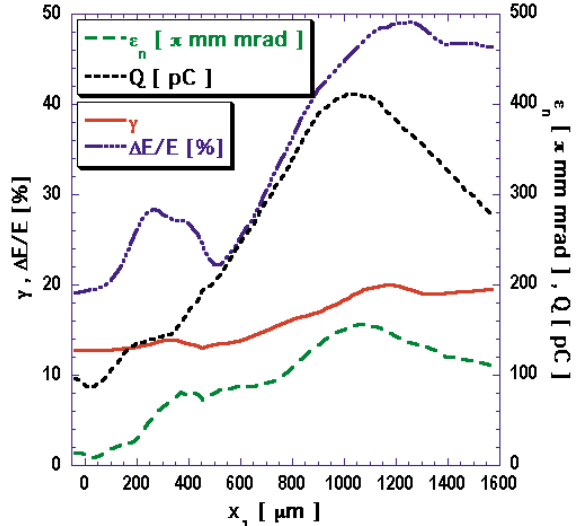
FIG. 8. (Color) The evolution of some important electron beam characteristics from the time after exiting the first gas jet until after exiting the second gas jet. The data are for a second gas jet with w 2 (cid:1) 1.5 mm, L g 2 (cid:1) 0.5 mm, and n p 2 (cid:1) 1.0 3 10 18 cm 2 3 . The beam energy g , the relative energy spread D E (cid:3) E , the normalized emittance e n , and the beam charge Q are shown. Only electrons with p 1 $ 10 mc were included in the calculation of the numbers shown in the